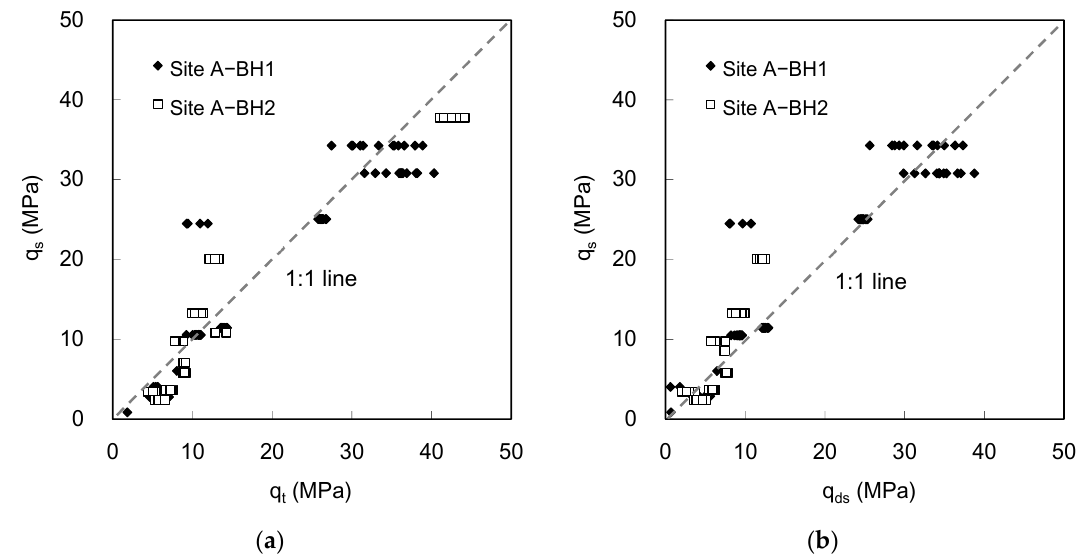
Figure 18. Comparison of the static cone resistance obtained using ICP—q s with ( a ) the total cone resistance—q t and ( b ) static component of the total cone resistance—q ds . Table 3. Estimation of the dynamic cone resistance based on Lysmer’s analog. Depth